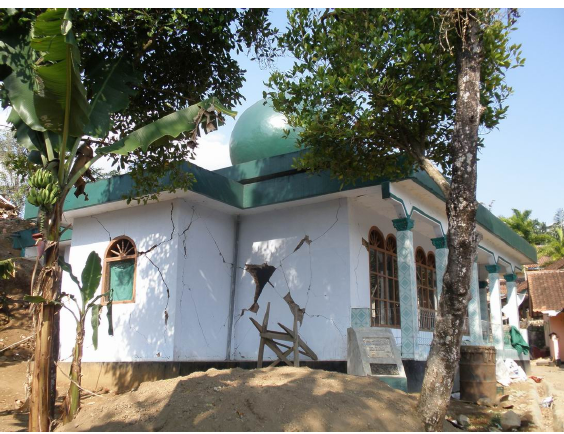
Figure 1. Masonry wall damage of West Java earthquake, Indonesia (2009).